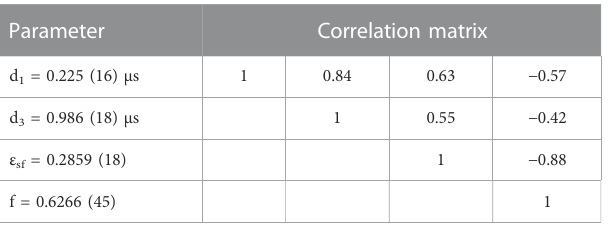
TABLE 10 Parameters for the empirical dead time correction, gate fraction and detection ef fi ciency derived from measurements with certi fi ed 252 Cf(sf)